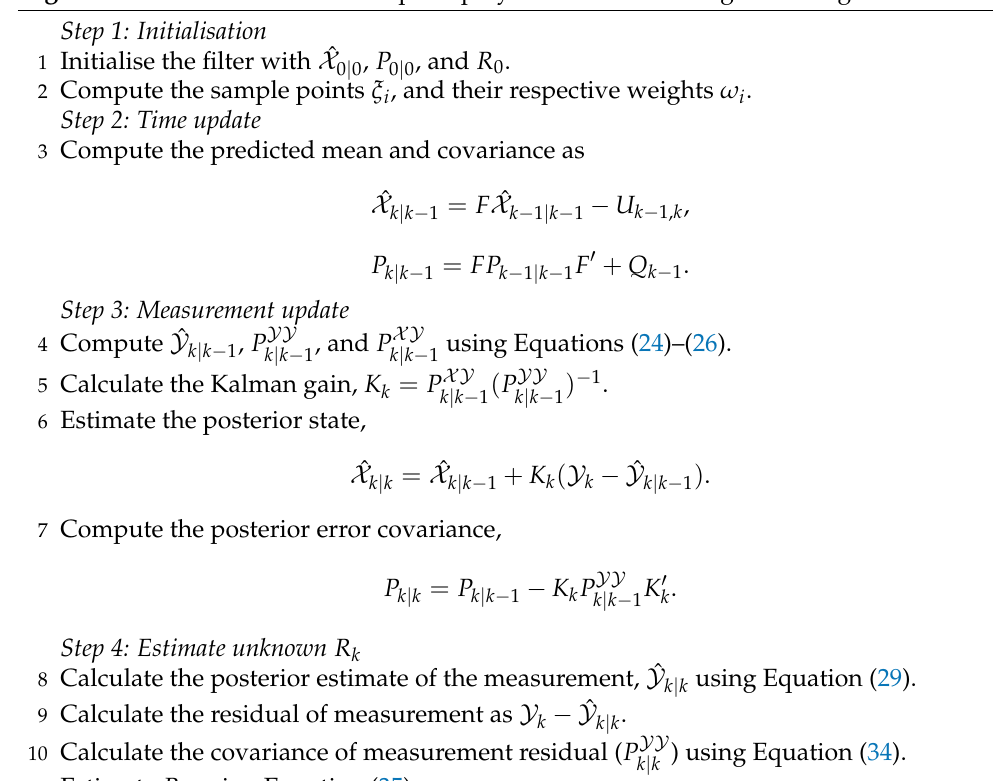
Algorithm 1 : Pseudo code for adaptive polynomial filter for target